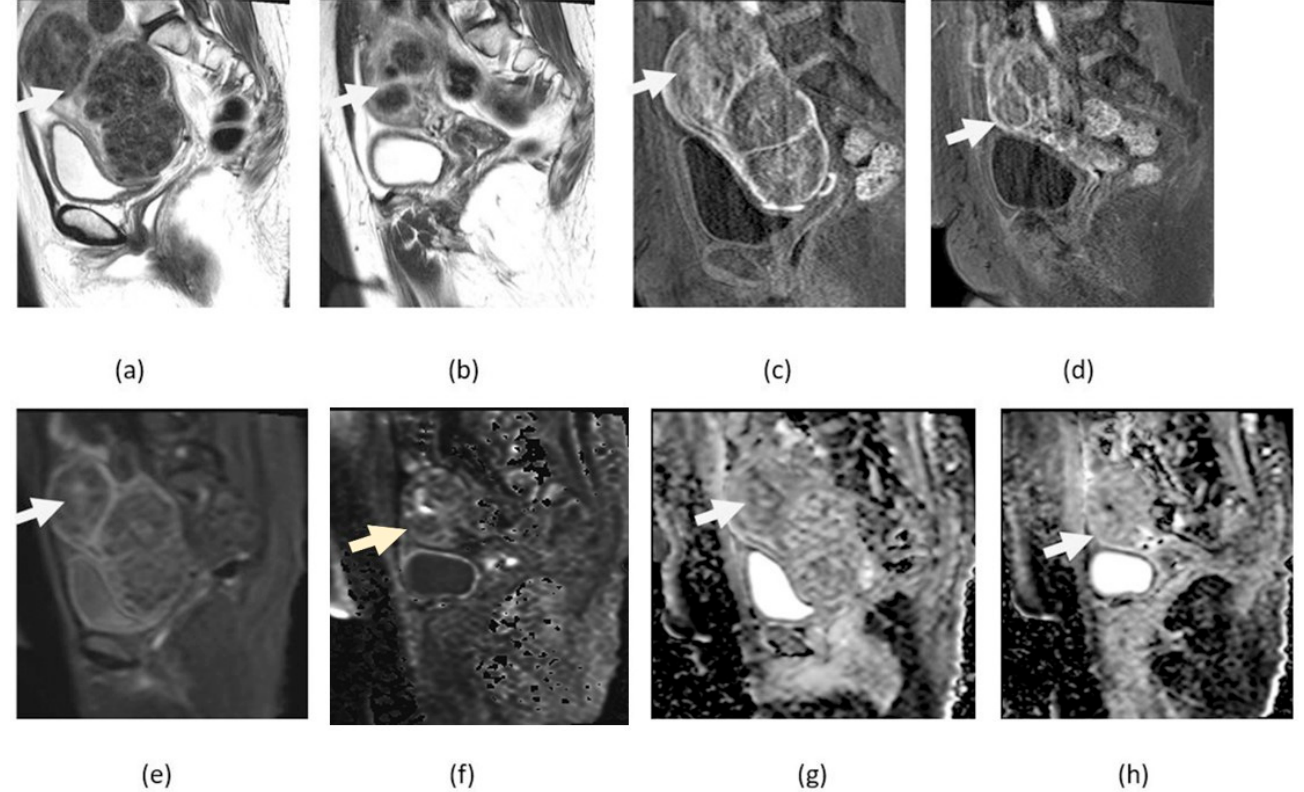
Figure 5. Multiple myometrial nodules consistent with leiomyomas on sagittal T2-weighted images ( a , b ) and sagittal contrast-enhanced fat-suppressed T1-weighted ( c , d ), before and after treatment with embolization, some fibroids identified with arrows. After treatment, there is a decrease in size and absence of diffusion restriction shown in the sagittal DWI ( e , f ) and ADP maps ( g , h ), findings that are consistent with treatment response.